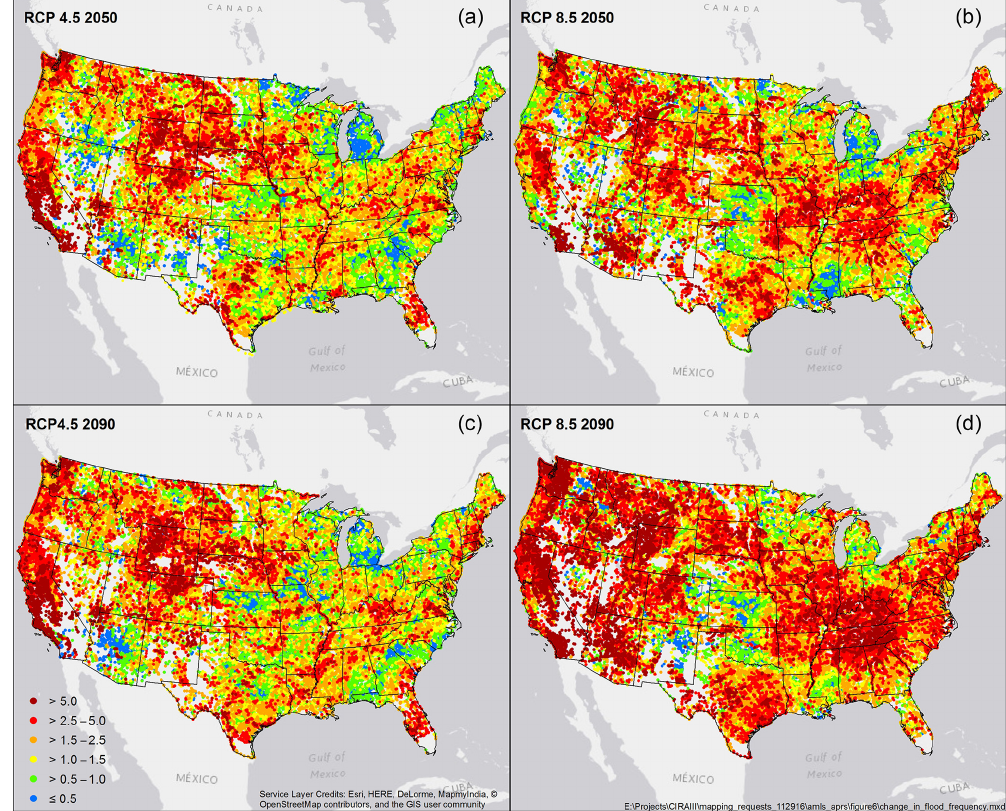
Figure 6. Change in frequency of historical 1% AEP events based on ensemble averages for specified RCPs and time periods. Calculations are based on individual stream segments over 20-year periods centered on (a) 2050 for RCP 4.5, (b) 2050 for RCP 8.5, (c) 2090 for RCP 4.5, and (d) 2090 for RCP 8.5. Values are expressed as ratios (e.g., a value of 2 corresponds to a doubling in frequency of the historical 1% AEP